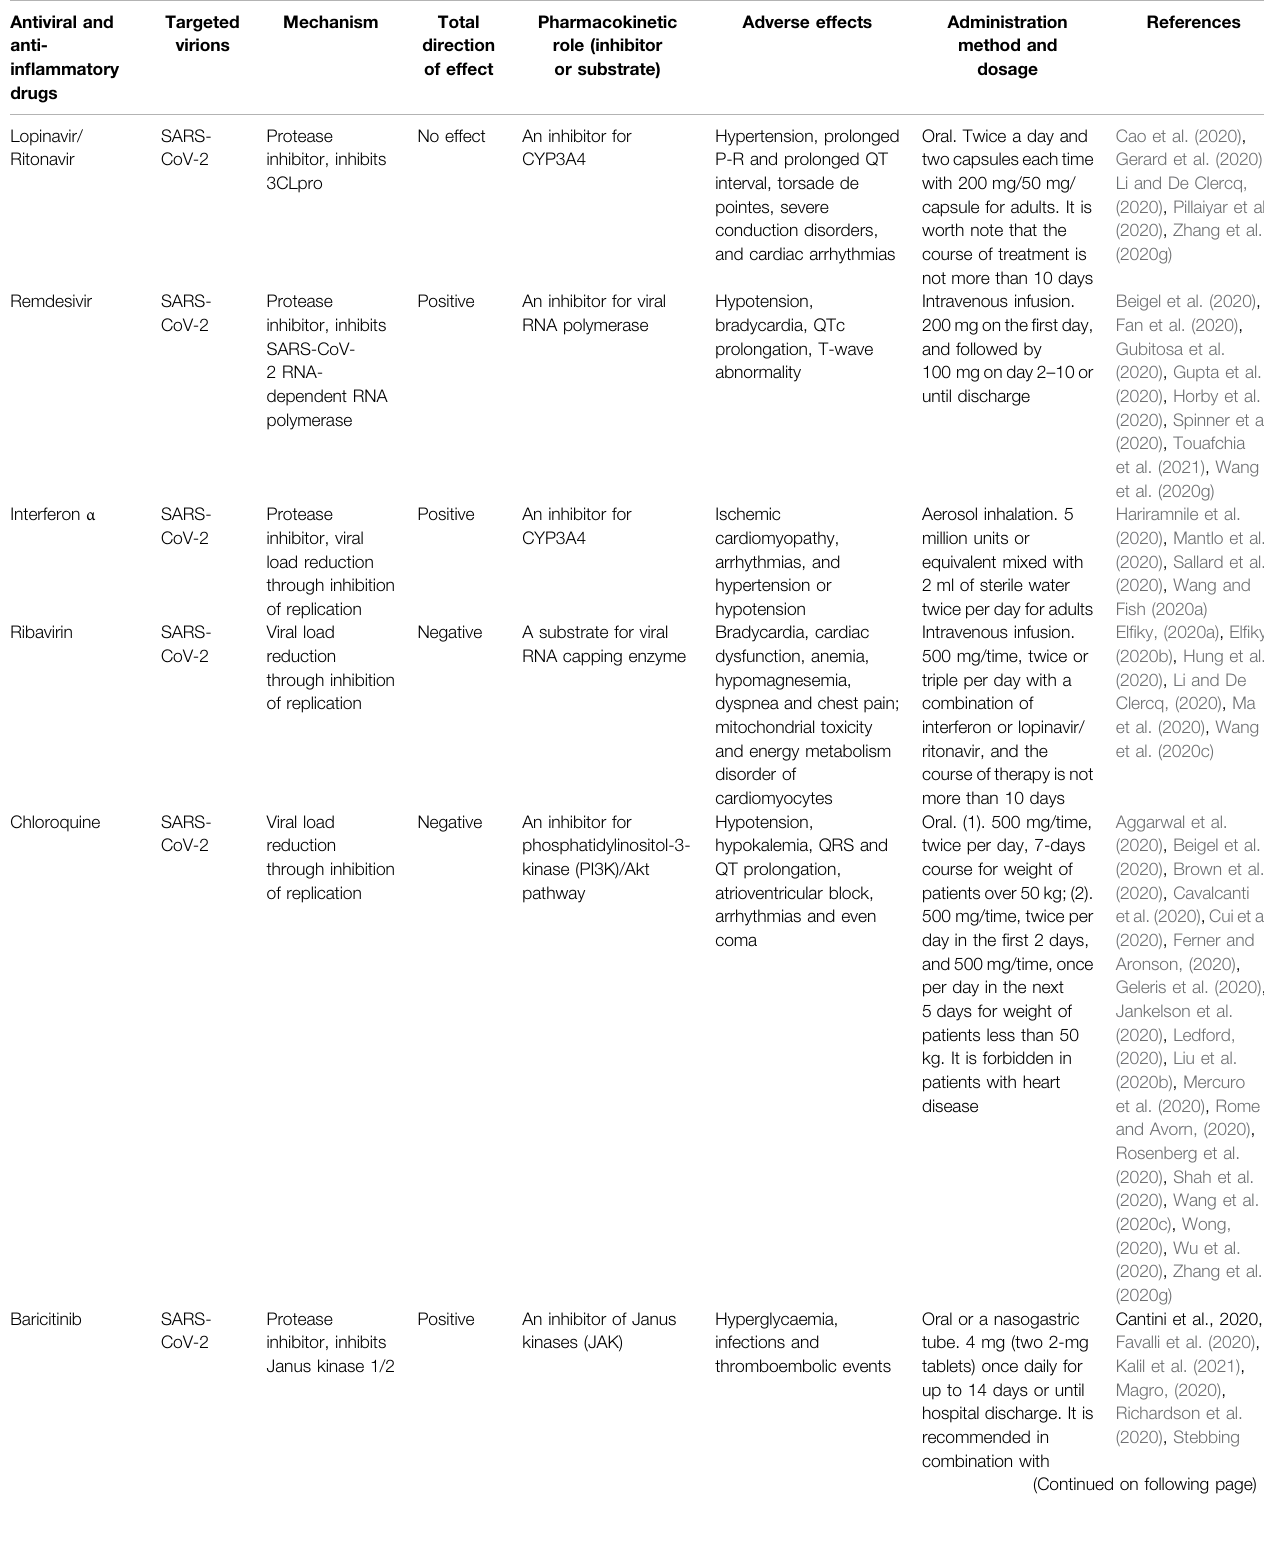
TABLE 1 | Antiviral and anti-in fl ammatory drugs that have been suggested for the treatment of COVID-19 infection. Antiviral and